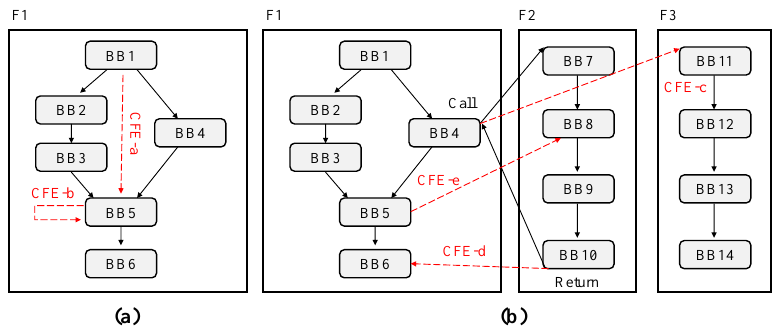
Figure 3. ( a ) Cases of inter-block CFE; and ( b ) cases of inter-procedural